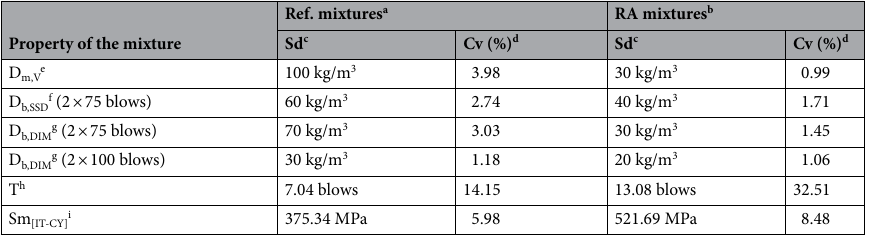
Table 1. Statistical dispersion parameters of the laboratory results. a Reference mixtures without rubber; b Rubberized asphalt mixtures; c Standard deviation; d Coefficient of variation; e Theoretical maximum density; f Bulk density (saturated surface dry [SSD] procedure); g Bulk density (geometric [DIM] procedure); h Resistance to compaction by impact; i Stiffness modulus by indirect tensile tests on cylindrical